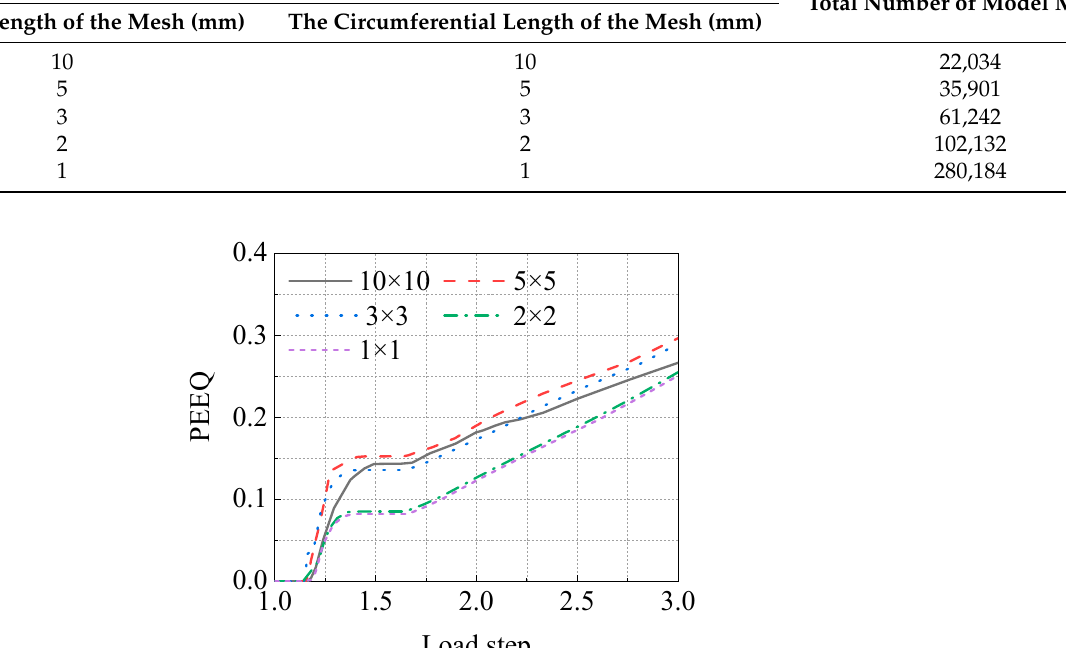
Table 3. Different mesh sizes and amounts for mesh sensitivity analysis.